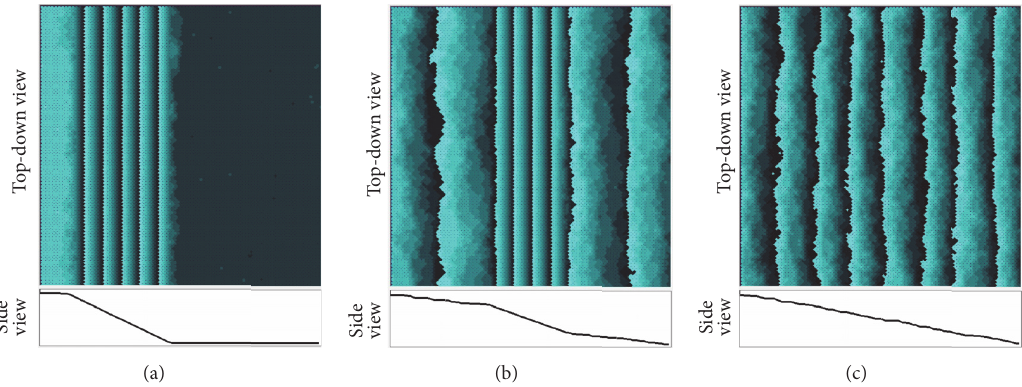
Figure 6: Top-down and side views of vicinal surfaces calculated by the Monte Carlo method. (a) 𝑘 𝐵 𝑇/𝜖 = 0.6 , number of steps 𝑁 step = 60 . (b) 𝑘 𝑇/𝜖 = 0.63 , 𝑁 = 80 . (c) 𝑘 𝑇/𝜖 = 0.73 , 𝑁 = 60 . 𝜖 /𝜖 = −0.9 . Size: 80√2 × 80√2 . Time: 2 × 10 8 Monte Carlo steps per site (MCS/site). 𝐵 step 𝐵 step int The surface height in the top-down view is represented by brightness with 10 gradations, with brighter regions being higher. Because of the finite gradation, the height of the terraces with the darkest color is higher by one than the height of the terraces with the brightest color. The line in the side views shows the surface height on the bottom side of the top-down